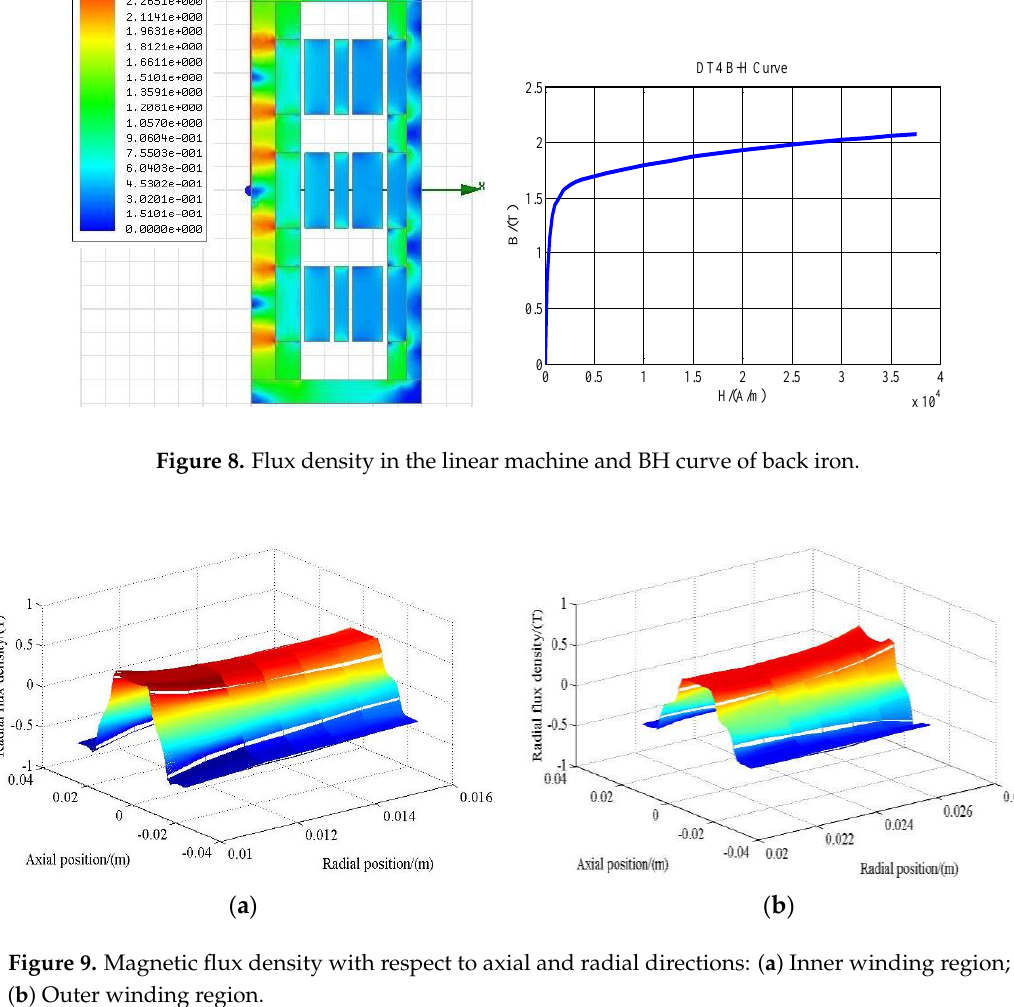
( c ) Figure 7. Magnetic flux distribution: ( a ) Initial position without power supply; ( b ) Initial position with power supply; ( c ) Maximum working position with power supply.